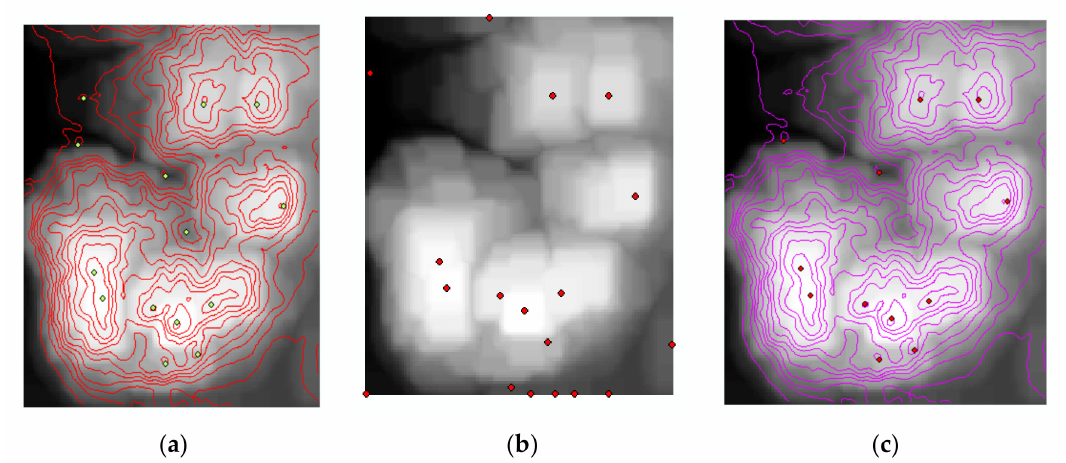
Figure 26. Distribution maps extracted by the traditional Mountain Vertices Extraction Methods using the fifth dataset. ( a ) Contour Line Method. ( b ) Neighborhood Analysis Method. ( c ) Contour line and Neighborhood Analysis Overlay Method.